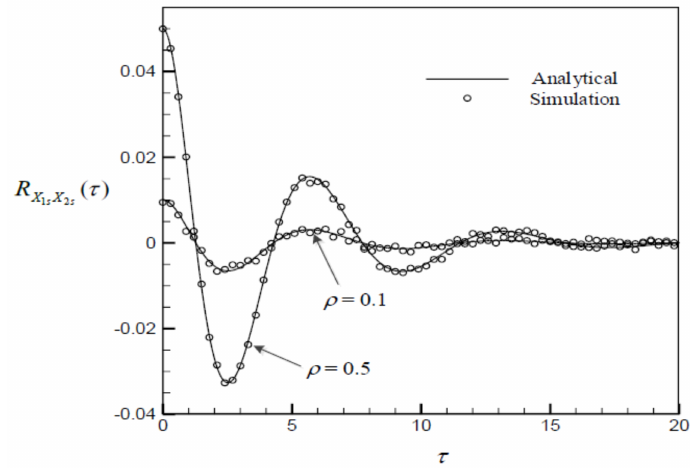
Figure 3. Cross − correlation functions of simulated excitations for σ 2 different values of ρ .